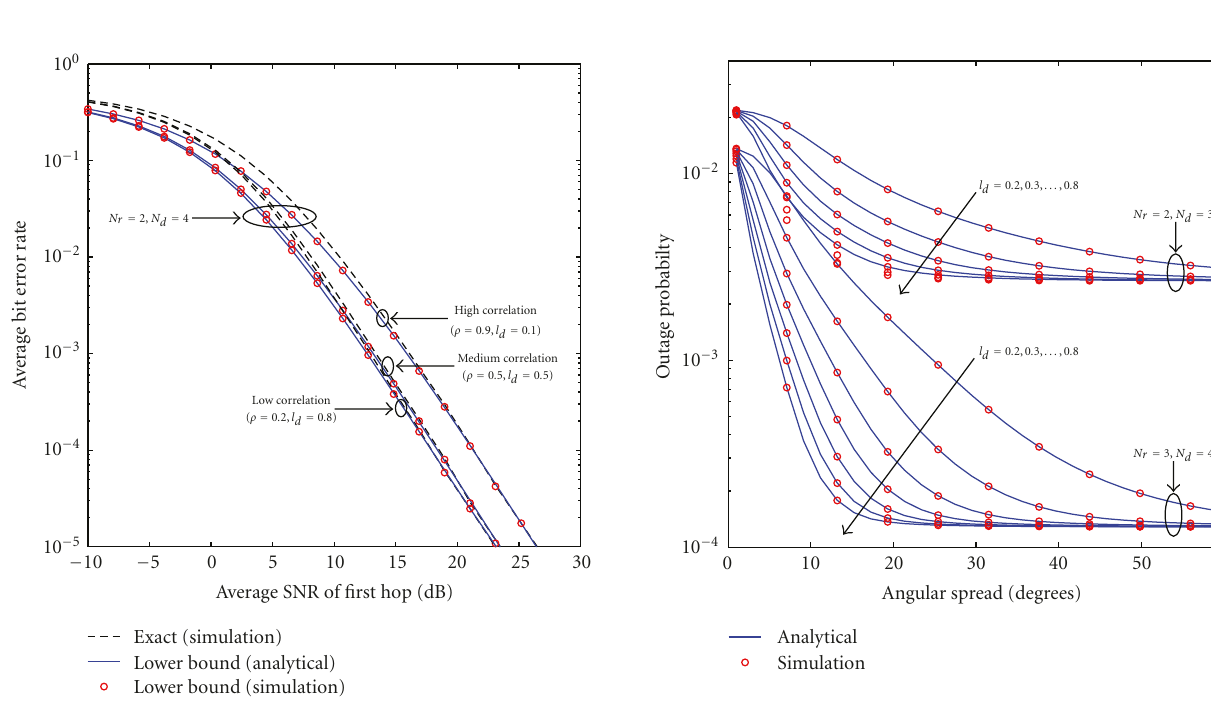
= γ / 2, θ d = 3 π/ 6, and 1 2